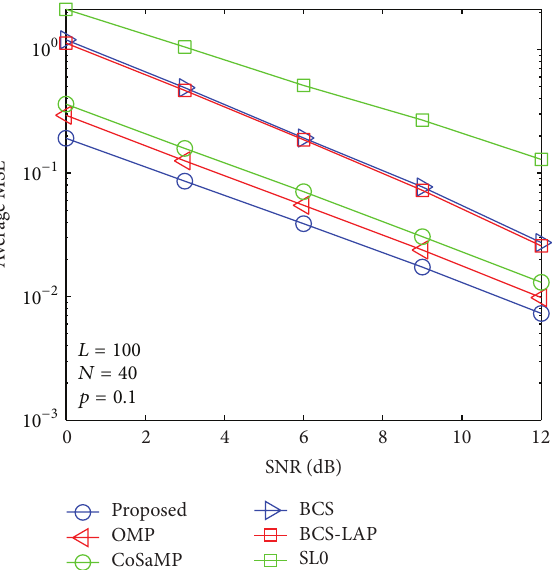
Figure 5: Average MSE performance versus SNR when 𝑝 1 = 0.1 and 𝑁 = 20 .